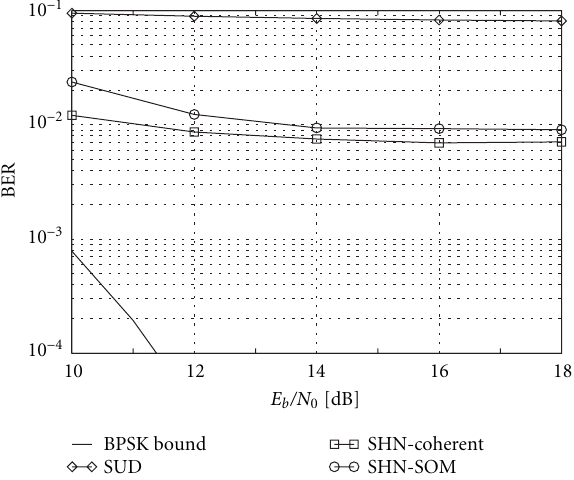
HPLOS with ext. gold HPLOS with W-H OPOBS with ext. gold OPOBS with W-H Figure 13: Frobenius norm versus number of iterations in the asyn- chronous